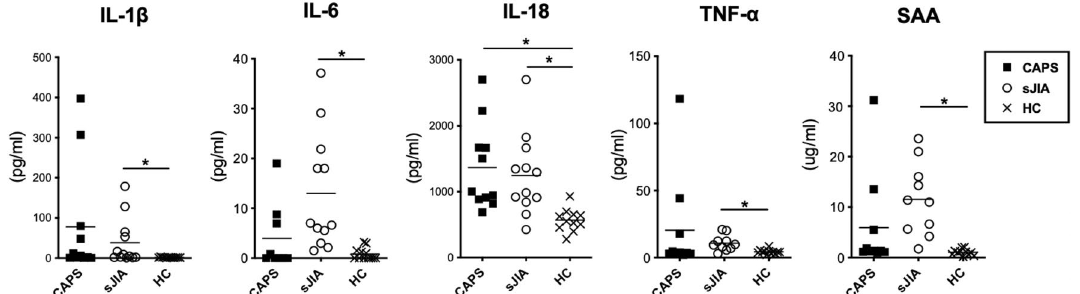
Figure 1. Levels of inflammatory cytokines and serum amyloid A in patients’ plasma. Levels of inflammatory cytokines IL-1β, IL-6, IL-18, TNF-α and SAA were measured in cases with CAPS, sJIA and healthy controls. While the cytokines were globally elevated among the sJIA patients ( p < 0.05), the level of IL-6 within the sJIA patient plasma is increased as compared to those with CAPS with borderline significance ( p = 0.051). Data are presented with dot plot.* indicates p < 0.05. Abbreviations: CAPS- cryopyrin-associated periodic syndrome; sJIA-systemic juvenile idiopathic arthritis; HC- healthy controls; IL-1β- interleukin 1β; IL-6- interleukin 6; IL-18- interleukin 18; TNF ⍺ - tumor necrosis factor ⍺ ; SAA- serum amyloid